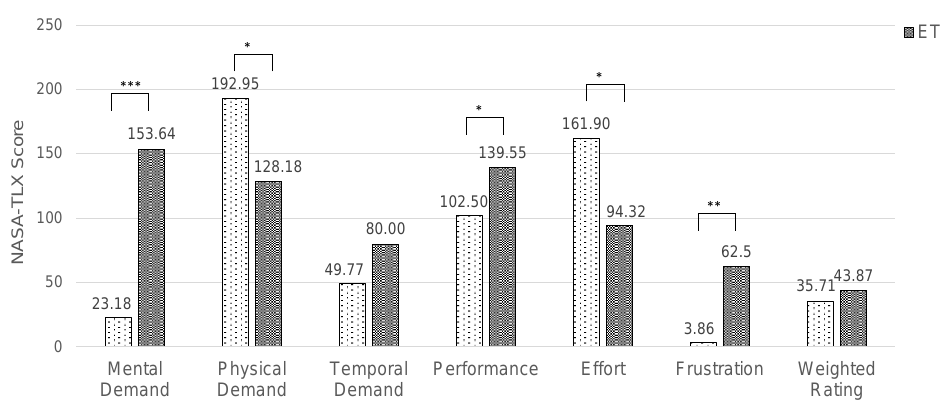
Figure 5. Results of the adjusted ratings of the subscales and the weighted rating of the NASA-TLX. The white columns represent the strength endurance training, and the gray ones represent the endurance training. Significance: * p < 0.05, ** p < 0.01, *** p < 0.001.